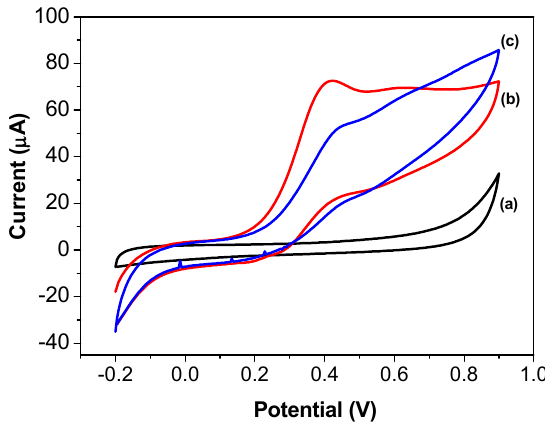
Figure 3. Cyclic voltammograms obtained using the screen-printed carbon electrode modified with AChE/CS/Fe 3 O 4 in (a) 0.1 mol L − 1 phosphate buffer solution at pH 7.4; (b) with addition of 20 mmol L − 1 ATCh; and (c) with addition of 20 mmol L − 1 ATCh plus 1.2 μ mol L − 1 of malathion.